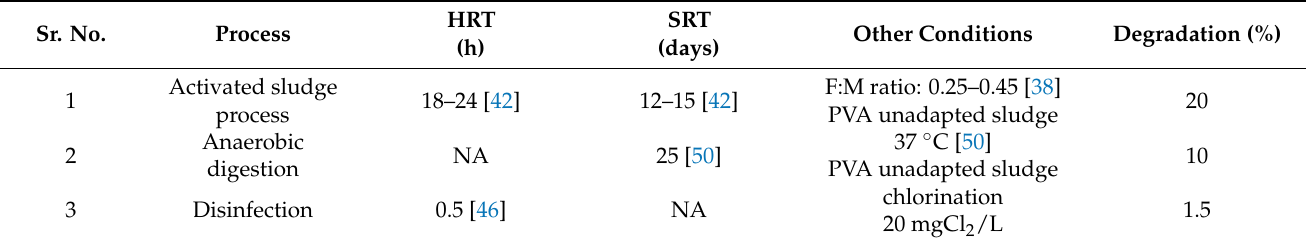
Table 2. The treatment section, corresponding degradation percentages, SRT, HRT, and other process conditions in a conventional sewage treatment plant. Other processes that do not contribute to degradation are excluded from this table. Sr.